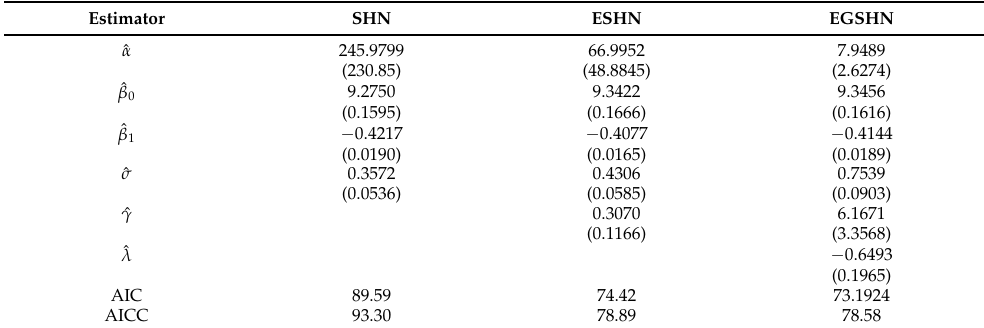
Table 4. Estimated parameters, with their standard errors for the SHN, ESHN, and EGSHN models. Estimator SHN